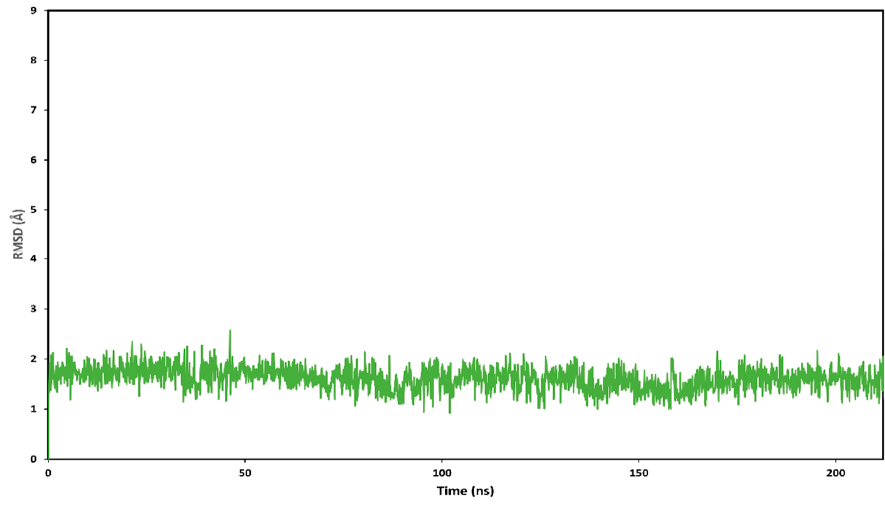
Figure 10. Analysis of the MD simulation of the predicted binding mode of HAA 2021 complexed with Hsp90. The plot shows the RMSD of the ligand disposition during the simulation with respect to its initial docking pose.